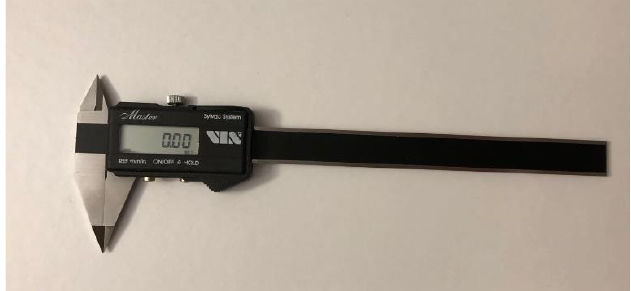
Figure 1. Electronic caliper.